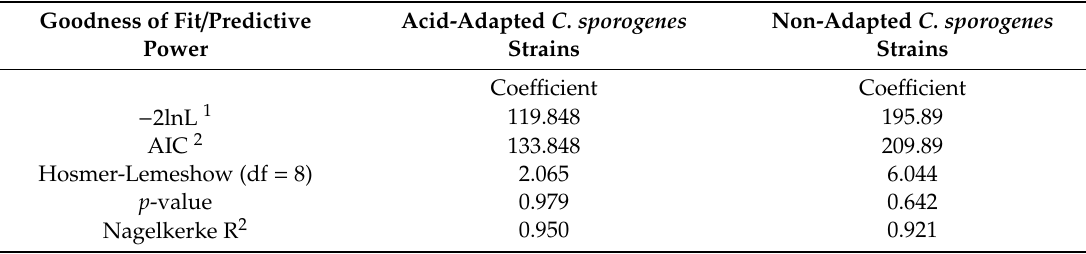
Table 3. Goodness of fit statistics for the logistic regression models of the acid-adapted and non-adapted C. sporogenes